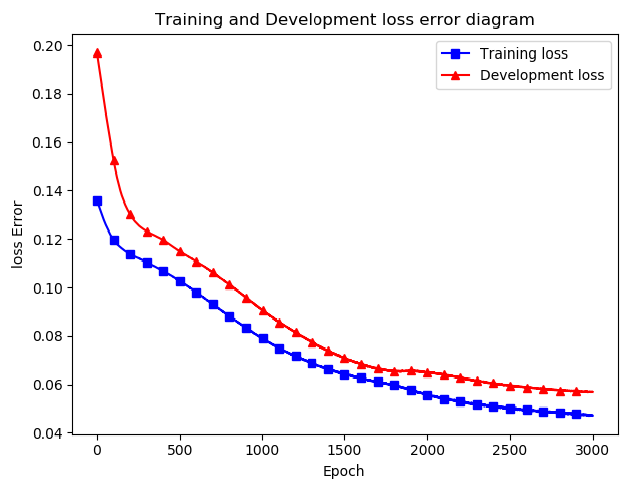
Fig. 5. Training and development loss error diagrams for conscientiousness trait classification in the UTS dataset evaluated by conventional 10-Fold